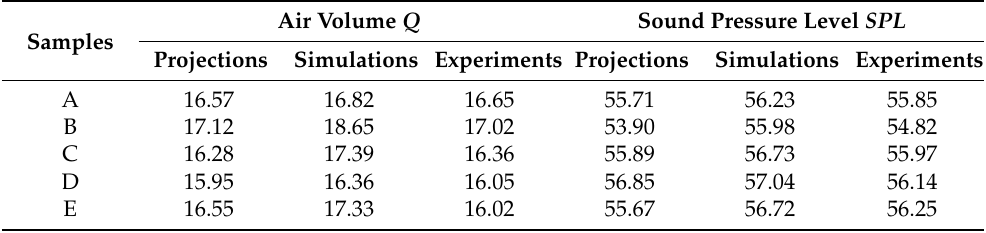
Table 3. Simulation accuracy